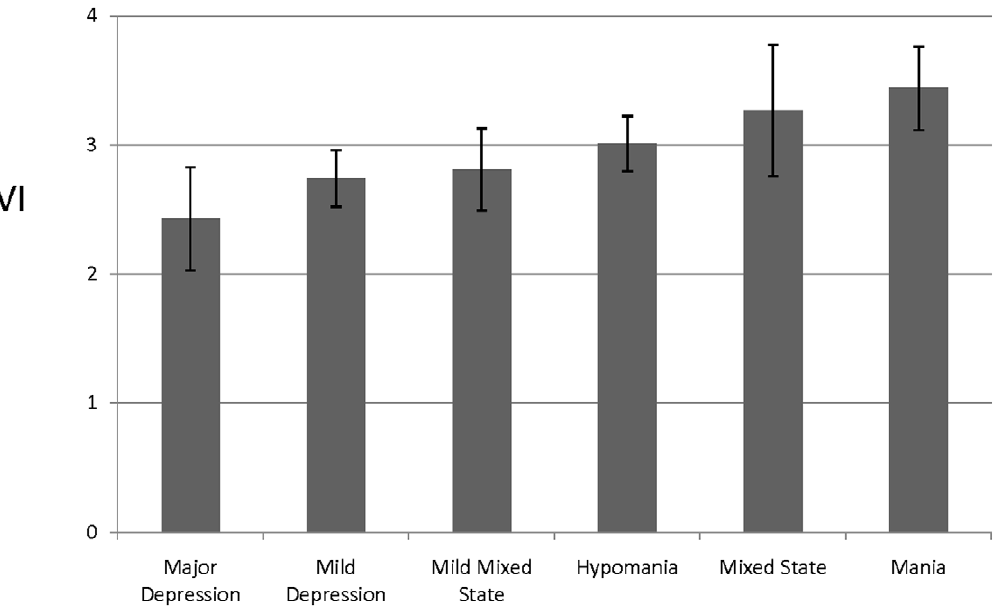
Figure 6. Mean ( ± SEM) computed vulnerabilityindex (VI) values associated with various mood states of patients meeting DSM-IV diagnostic criteria for type-I BD. VI rises consistently and significantly with increasing manic features, from major depression, through mild depression or dysthymia, subclinical or mild mixed manic-depression, hypomania, mixed major manic-depressive states, to current mania-all in BD